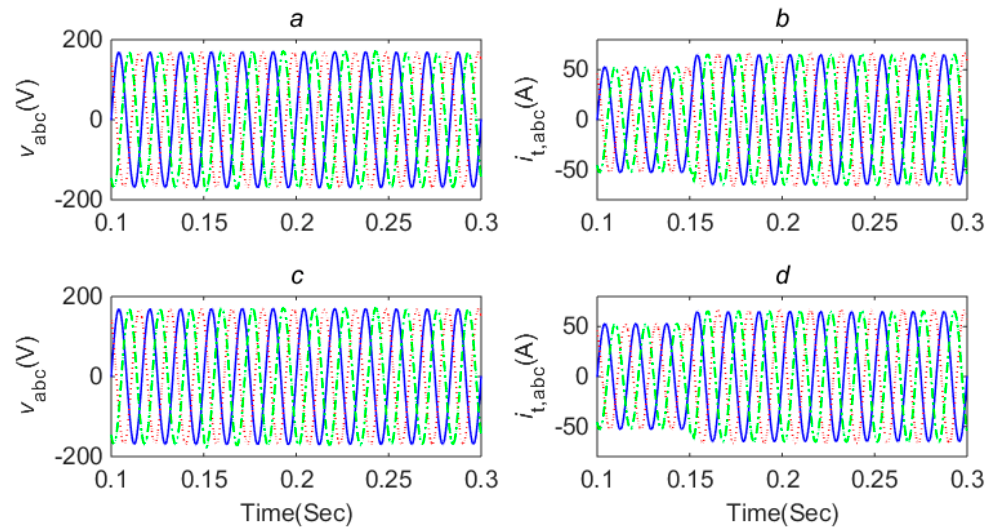
Figure 7. Output current of the main DGu and load voltage (( a , b ) are under RHOSM and ( c , d ) are under AHOSM).